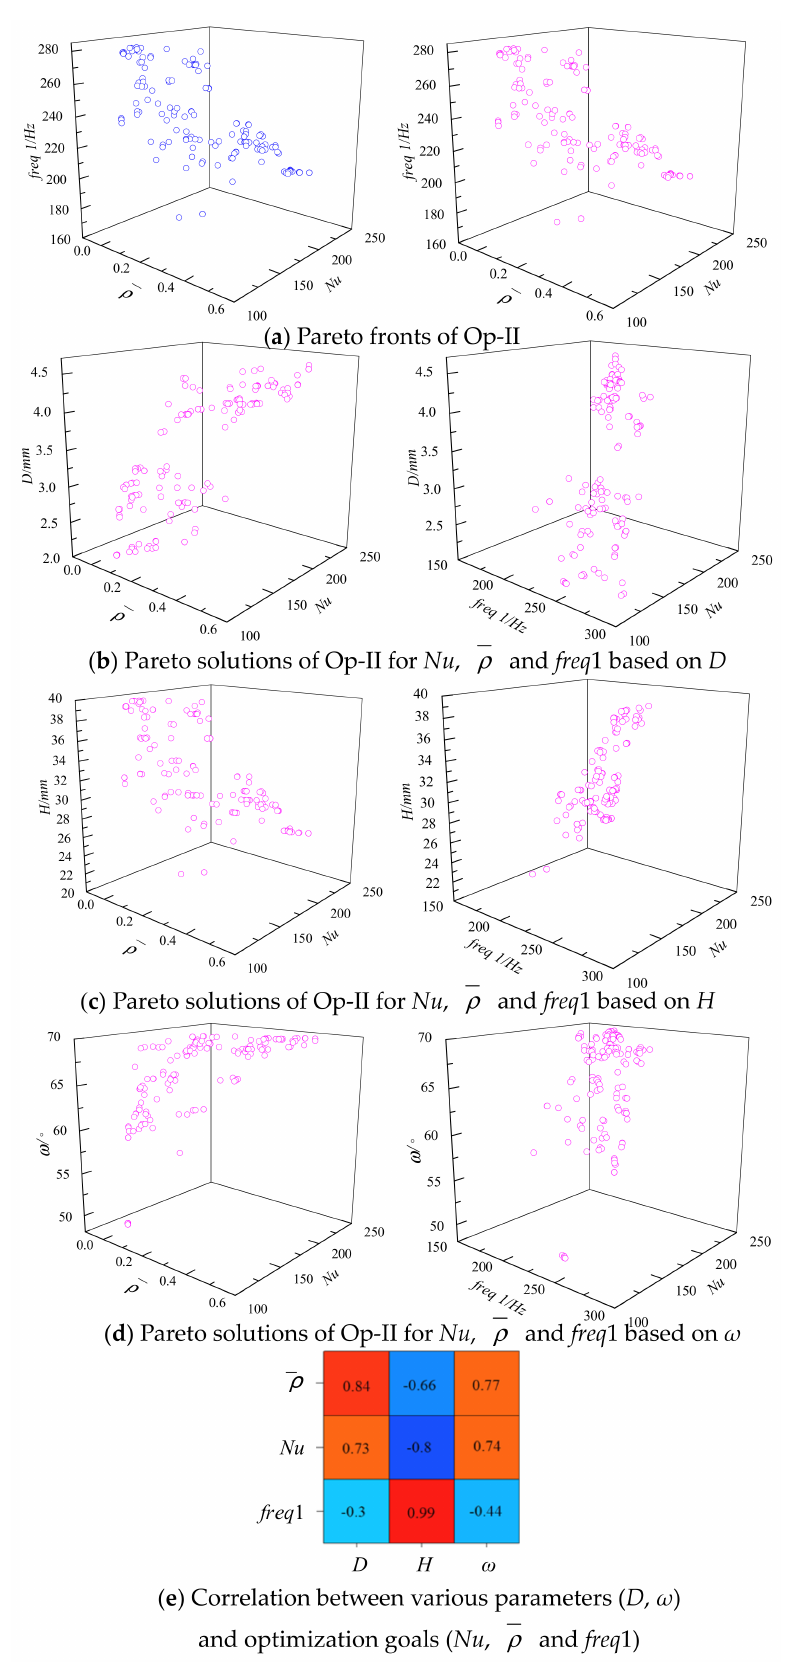
Figure 8. Sensitivity analysis for